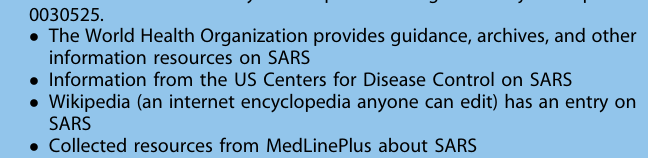
SARS (cid:2) Collected resources from MedLinePlus about